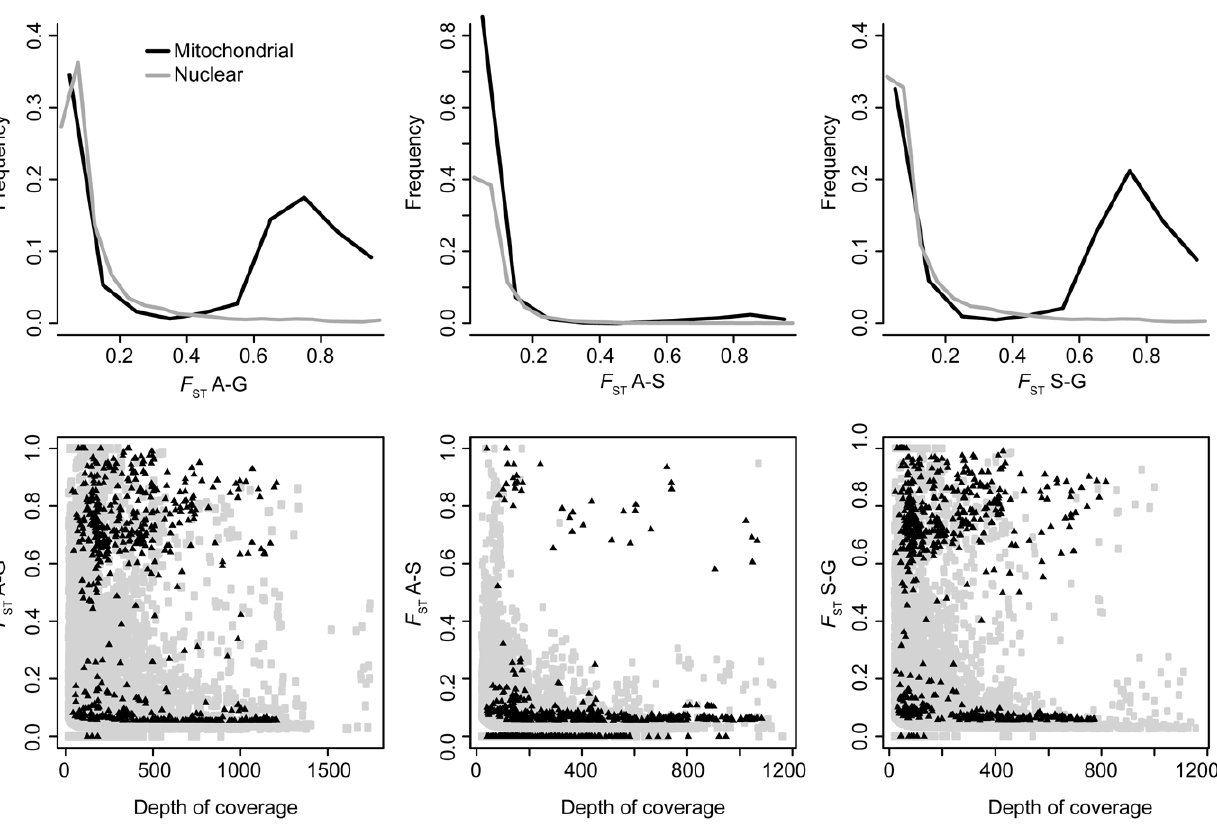
Figure 5. Pairwise F ST distributions. Top panel: frequency of F ST values for each pair of population. Bottom panel: relationship between depth of coverage and F ST values. On both panels, nuclear and mitochondrial loci are represented in grey and black, respectively.